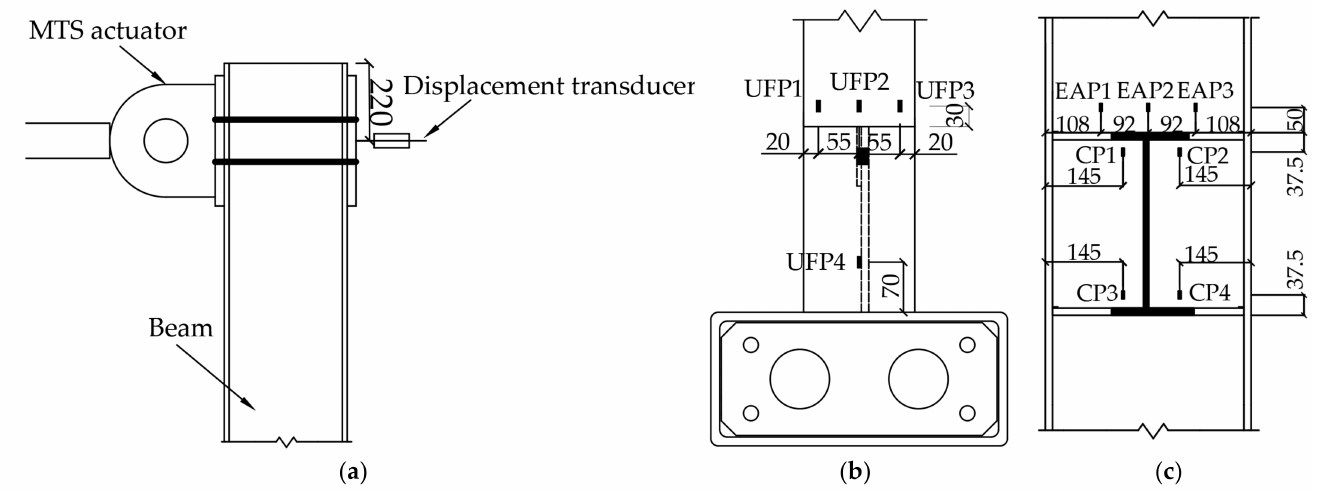
Figure 10. Arrangement of displacement transducer and strain gauges: ( a ) Location of displacement transducer; ( b ) Location of measuring points on beam flange; ( c ) Location of measuring points on flat CFST